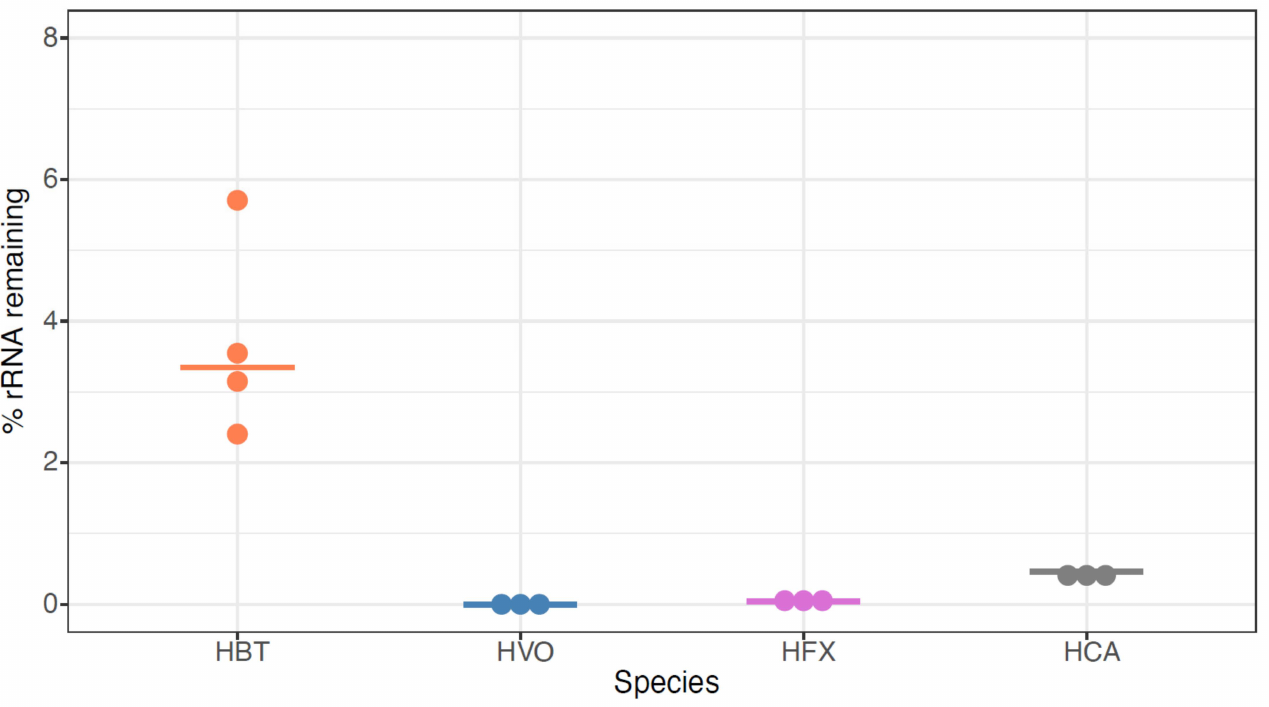
Figure 6. Panarchaea (rP-PA) kit efficiently removes rRNA from total RNA across halophilic species. Dotplots showing the percentage of the remaining counts mapping to rRNA genes in Hbt. salinarum (HBT, orange), Hfx. volcanii (HVO, blue), Hfx. mediterranei (HVO, purple), and Hca. hispanica (HCA, grey). Horizontal bars represent the median value of three biological replicate